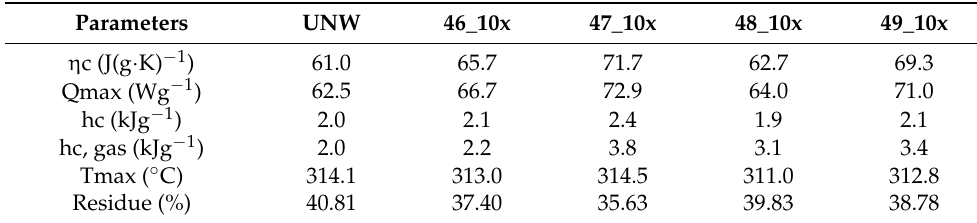
Table 8. Parameters of MCC analysis unwashed and 10-times-washed Proban ®